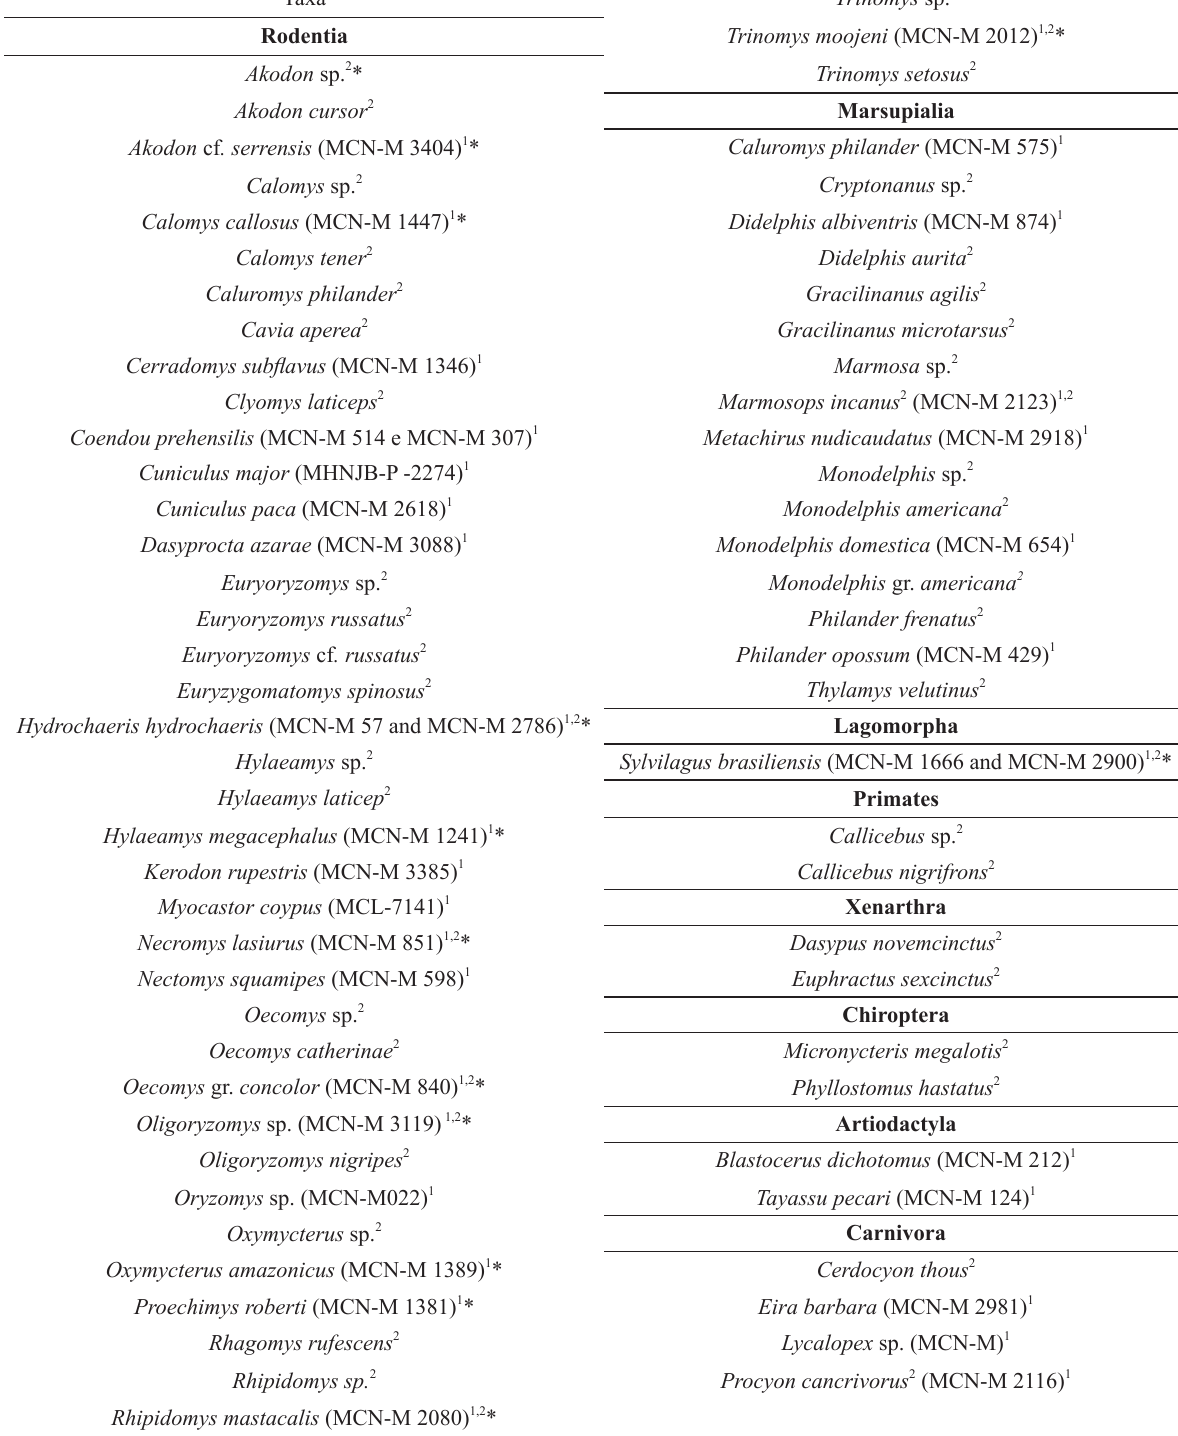
Figure 3 - List of the mammals used to produce the artificial traces in clay (¹). Mammals observed and/or collected in the region of the cave by the personnel of the Mastozoology Laboratory of PUC Minas Museum (²). tracemaking species that match the observed traces in the cave are marked with an